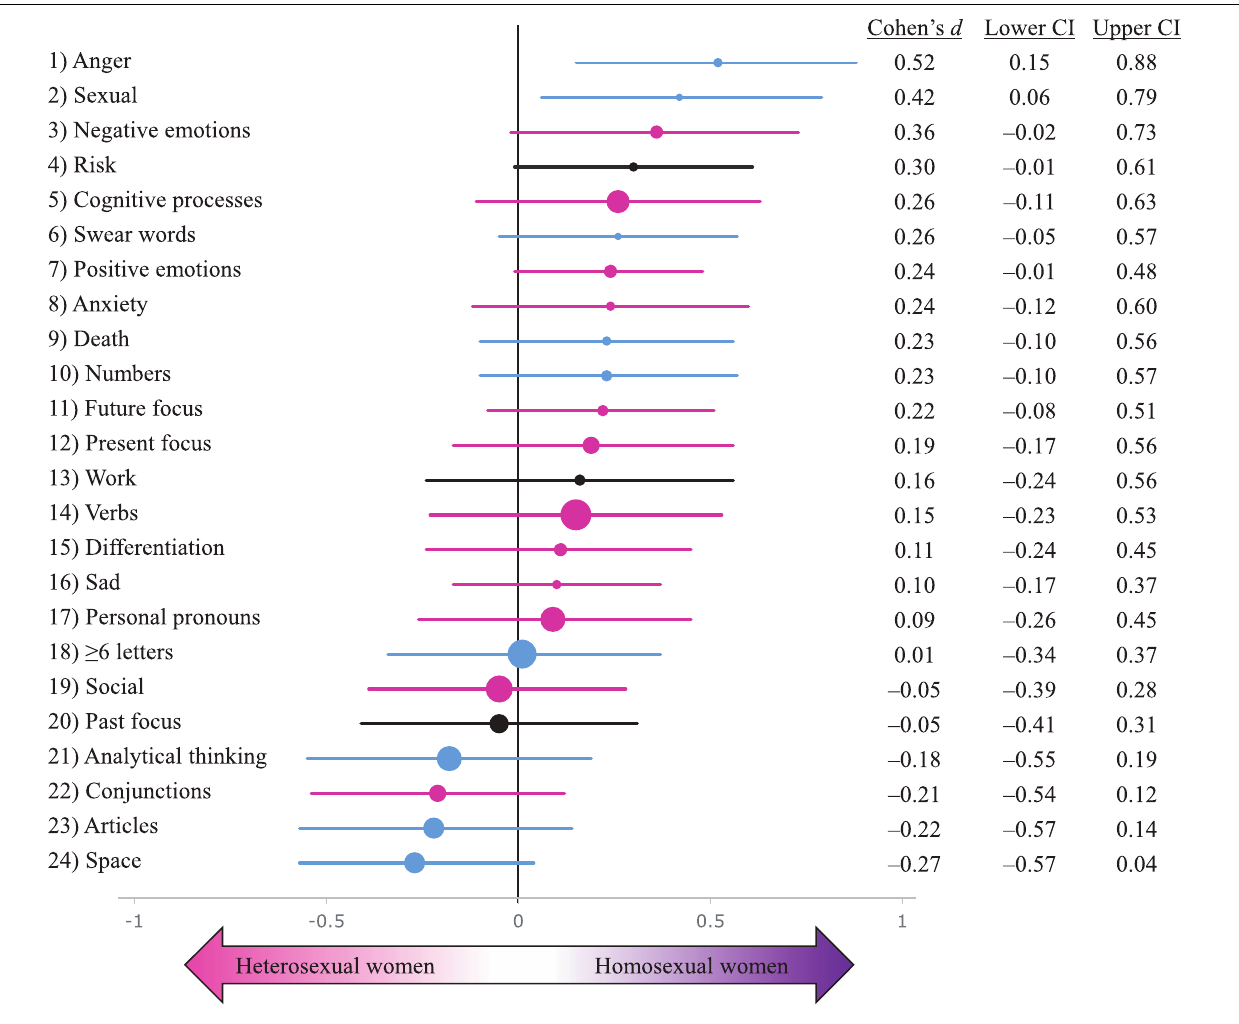
FIGURE 3 | A summary of multilevel sexual orientation effect sizes (Cohen’s d s) with 95% confidence intervals (CI) on 24 psycholinguistic variables. The sample comprised 311 novels by 85 heterosexual female novelists ( n = 153 novels) and 54 homosexual female novelists ( n = 158 novels). Cohen’s d s for each psycholinguistic variable are depicted as filled circles, which are scaled to reflect the prevalence of each word category in the sample: the larger the circle, the more frequently do words in that category occur in the sample. Positive d s represent higher scores in homosexual female authors’ novels; negative d s indicate higher scores in heterosexual female authors’ novels. Error bars represent 95% confidence intervals. The effect sizes and CIs presented here are calculated based on a multilevel model which includes publication year and author’s age at publication as covariates. The symbols are colour-coded based on the sex difference results ( Supplementary Table 8 ) so that blue = male-typical; magenta = female-typical; black = no sex